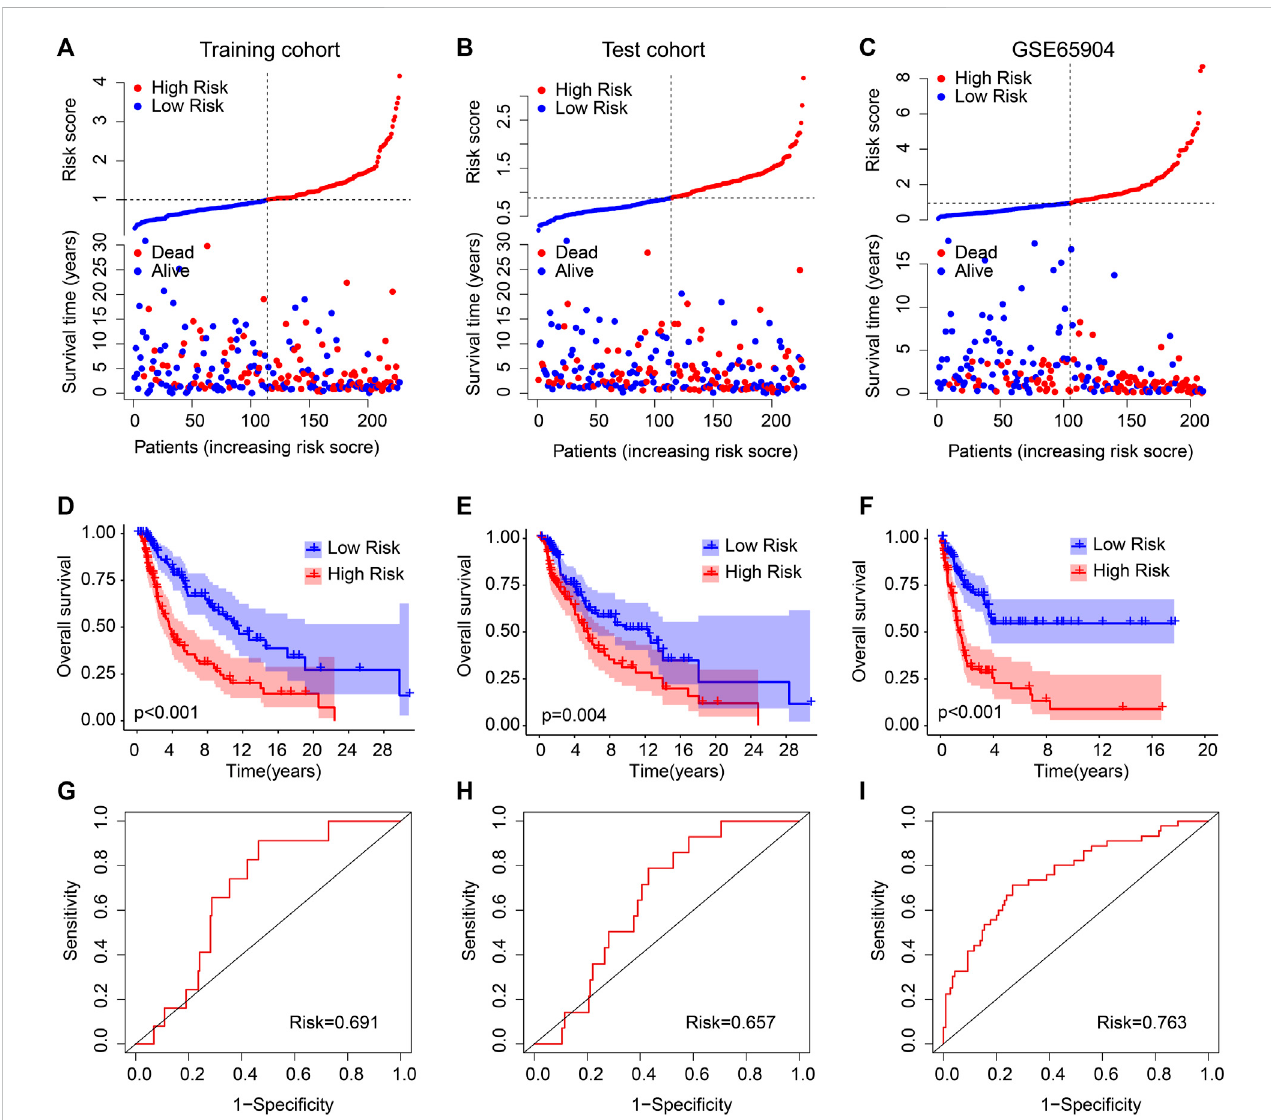
FIGURE 2 Validation of ARG prognostic signatures in CM. Risk model construction based on the ARG prognostic signatures in (A) training cohort, (B) test cohort, and (C) GEOcohort.TheKaplan – Meiersurvivalcurveanalysis ofthepatientsinthe (D) training cohort, (E) testcohort,and (F) GEOcohort.TheAUCoftherisk model in the (G) training cohort, (H) test cohort, and (I) GEO